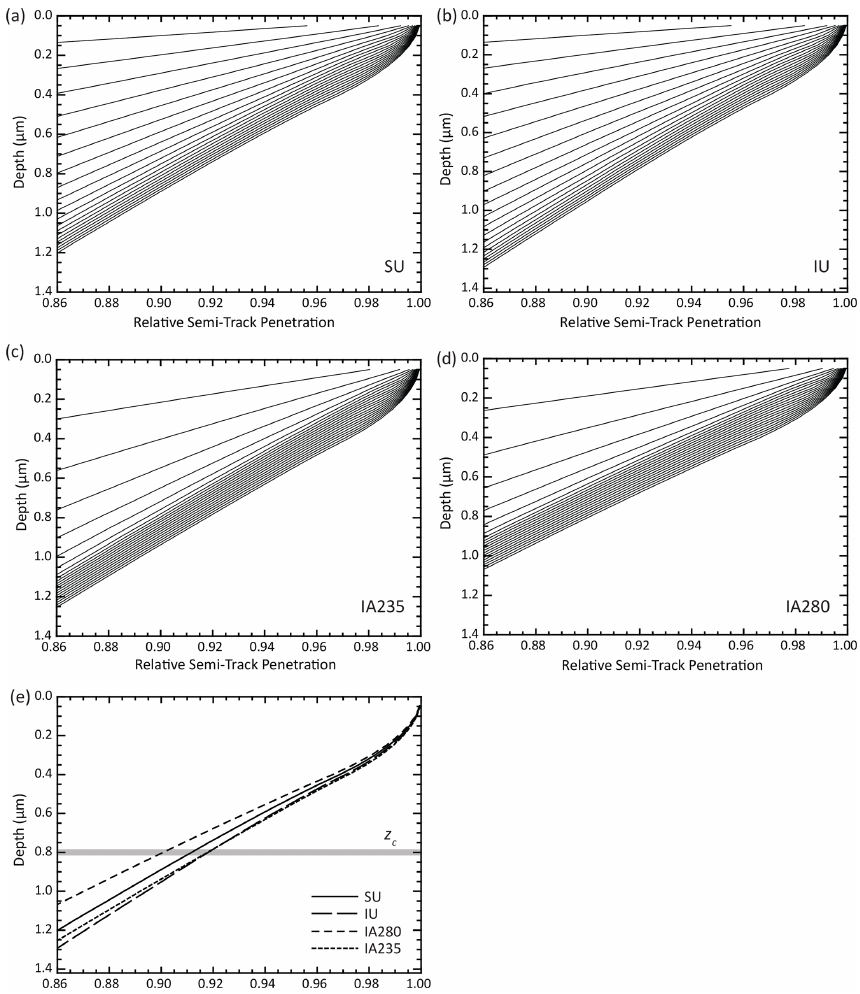
Figure 20. Penetration of randomly oriented semi-tracks into the grain interior from its polished surface, concentrating on the near-surface region (corresponding to upper right of Fig. 6a) for various track types: (a) SU unannealed spontaneous; (b) IU unannealed induced; (c) IA235 annealed induced (235 ◦ C, 24h); (d) IA280 annealed induced (280 ◦ C, 24h). In (a) – (d) , each line represents penetration in 1s increments from upper left to bottom right from 1 to 20s after etching begins. (e) 20s lines for each model, showing the estimated degree of semi-track penetration after a standard 20s etch. Depth of penetration may be the primary factor in determining whether a track is counted during age determination. The gray bar shows z c , which is the estimated critical depth that a semi-track must penetrate to be confidently observed and counted (Jonckheere and Van Den Haute,